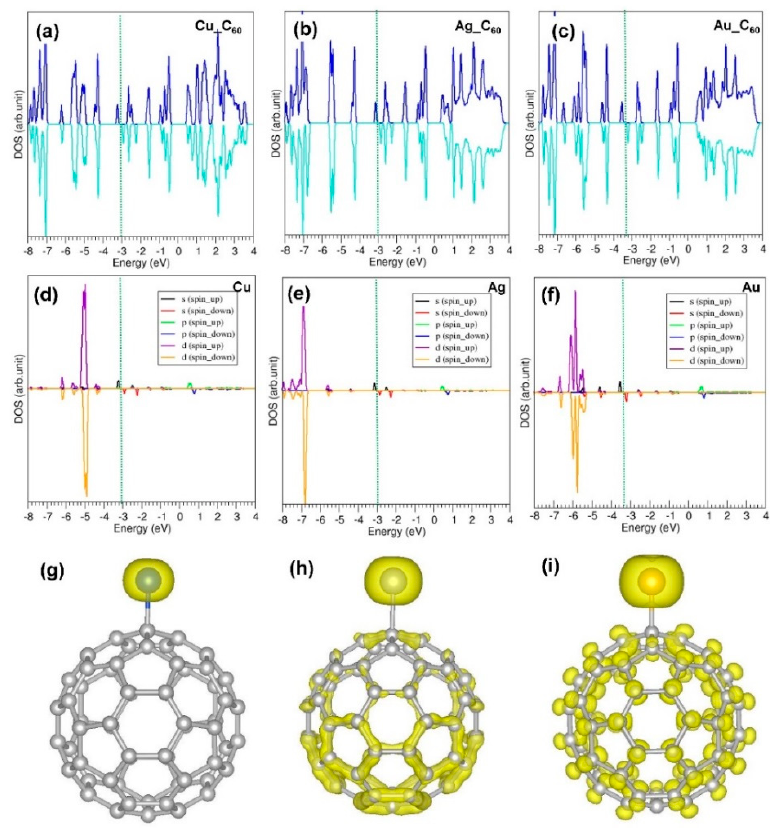
Figure 6. ( a )–( c ) Total DOSs for Cu, Ag and Au, respectively; ( d )–( f ) atomic doses for Cu, Ag and Au, respectively; and ( g )–( i ) charge density distributions around the adsorbed metal atoms for Cu, Ag and Au, respectively.